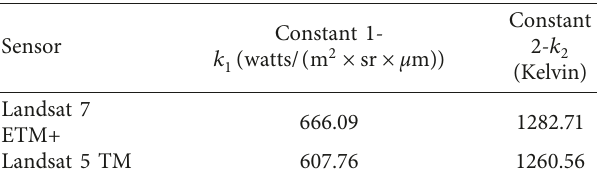
Table 3: ETM+ and TM band-specific thermal conversion